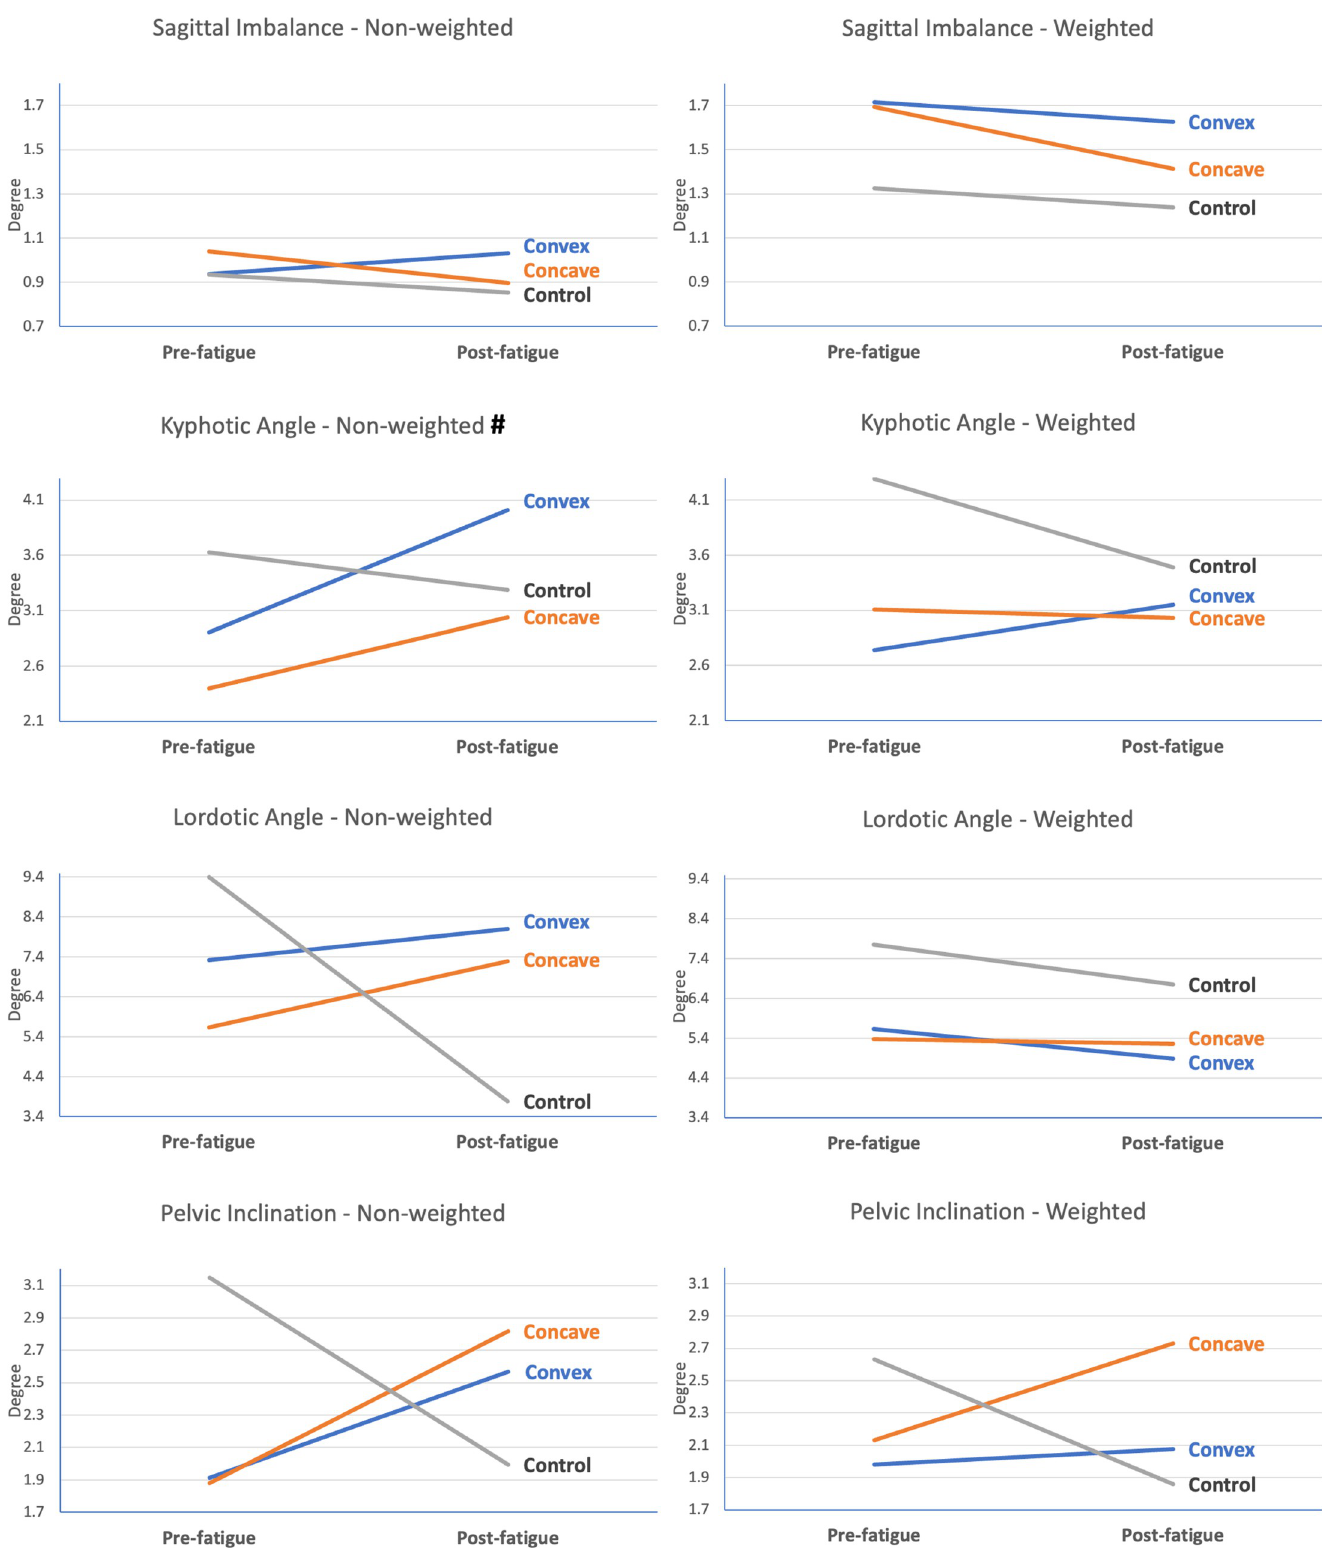
Fig 6. Sagittal-plane spinal kinematics during weighted and non-weighted functional tasks at pre- and post-fatigue. # represents significant time effect between pre- and post- fatigue measurement (p < 0.05). https://doi.org/10.1371/journal.pone.0281001.g006 PLOS ONE | https://doi.org/10.1371/journal.pone.0281001 January 27,